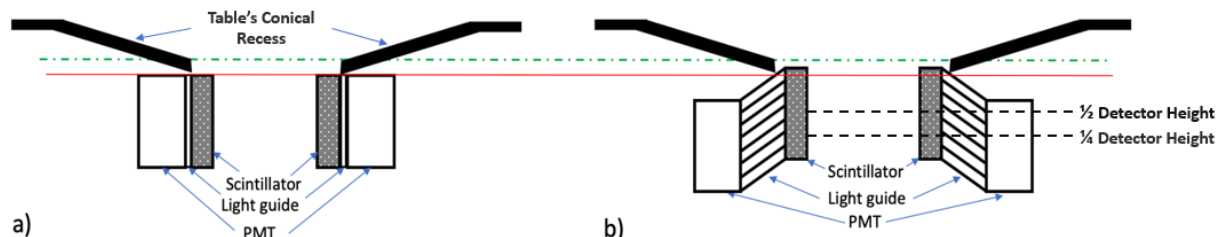
Figure 2. Schematic illustration of the slanted light guide geometry. ( a ) classic detector module design using thin, straight light guides to couple scintillator and PMT; ( b ) the module design used in the BRPET scanner, including the thicker slanted light guides. The dotted green line represents the top surface of the hole in the ventral end of the table’s conical recess, and the red line indicates the physical limitation of the classic design.